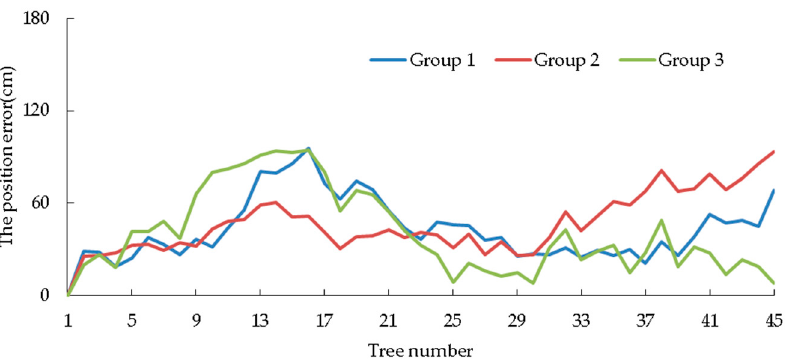
Figure 16. The position error of the tree.